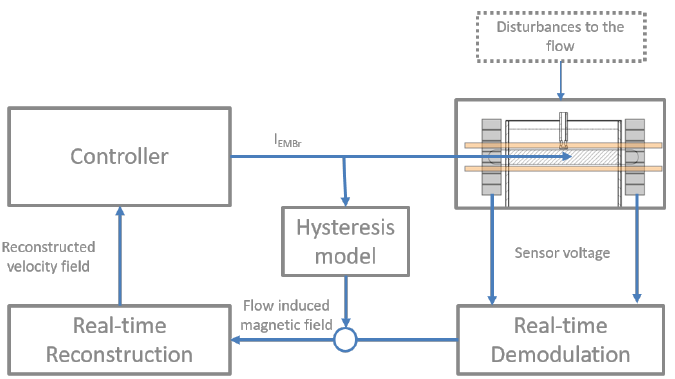
Figure A1. Block diagram showing the flow of information between the parts of the experiment.